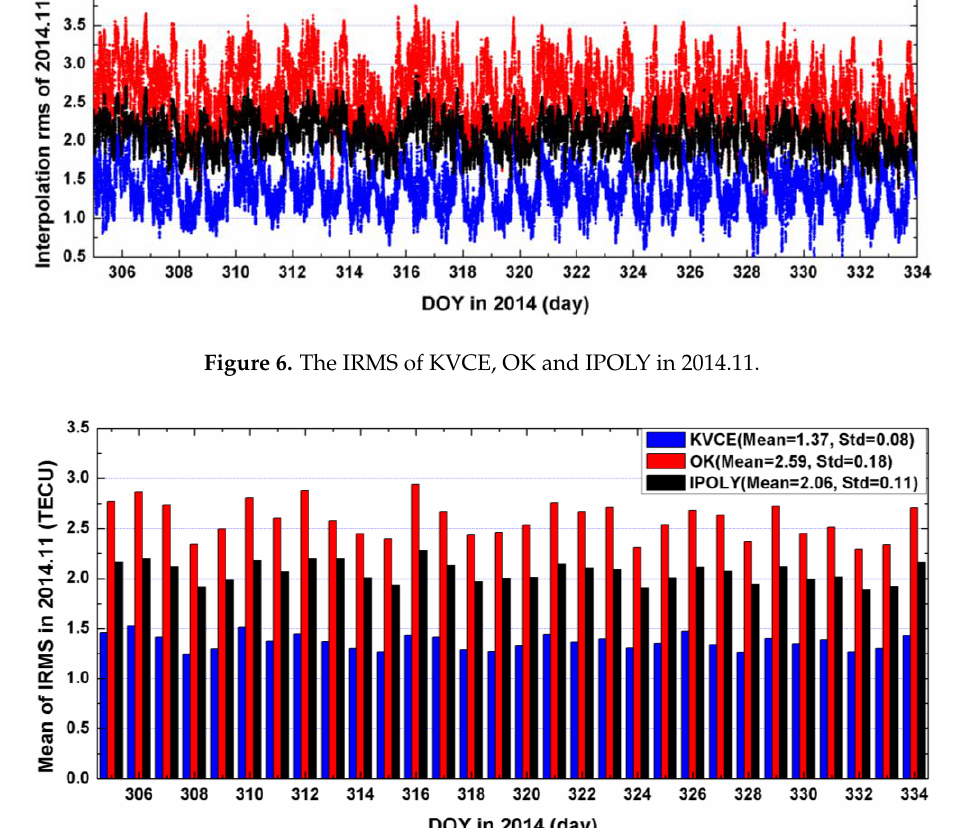
Figure 7. The daily mean of IRMS for KVCE, OK and IPOLY in 2014.11.